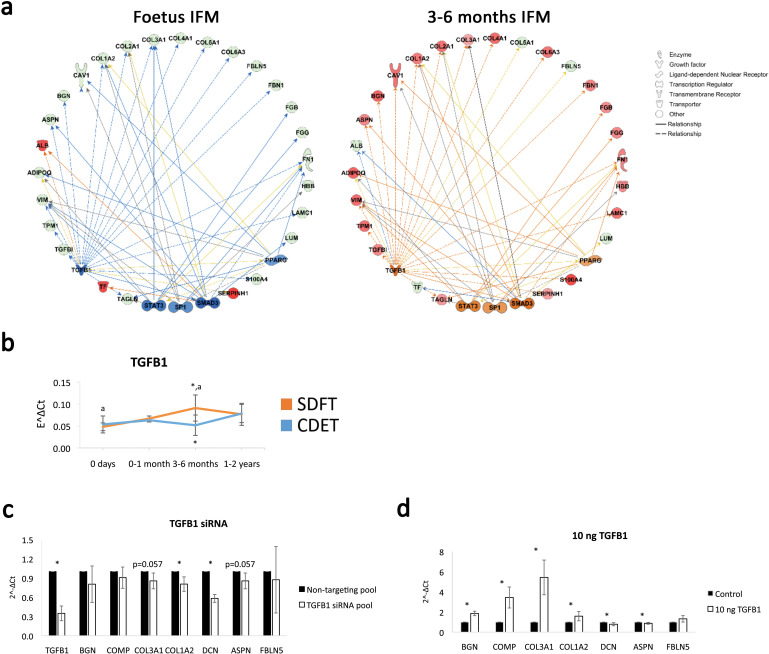
TGFB1 is predicted to be involved in compositional changes observed in the IFM.(a) IPA networks for TGFB1 as an upstream regulator were generated for the foetus and 3–6 months SDFT IFM proteomic datasets. TGFB1 regulation in the IFM is predicted to be inhibited in the foetus and activated at 3–6 months in the SDFT. Red nodes, upregulated proteins, green nodes, downregulated proteins, intensity of colour is related to higher fold-change, orange nodes, predicted upregulated proteins in the dataset, blue nodes, predicted downregulated proteins. (b) Whole tendon relative mRNA expression for TGFB1 in the SDFT and CDET during postnatal development shows an increase in TGFB1 mRNA in the 3–6 months highly loaded SDFT only. * Significant difference between tendons, a significant difference between age groups. (c–d) Relative mRNA expression of major ECM genes predicted to be regulated by TGFB1 in the IPA network following TGB1 knockdown (c) and stimulation with 10 ng recombinant TGF-β1 (d) for 24 hr. BGN, DCN, COMP, COL1A2 and COL3A1 show regulation following TGFB1 knockdown or addition. * Significant difference between control and treatment. Error bars depict standard deviation.